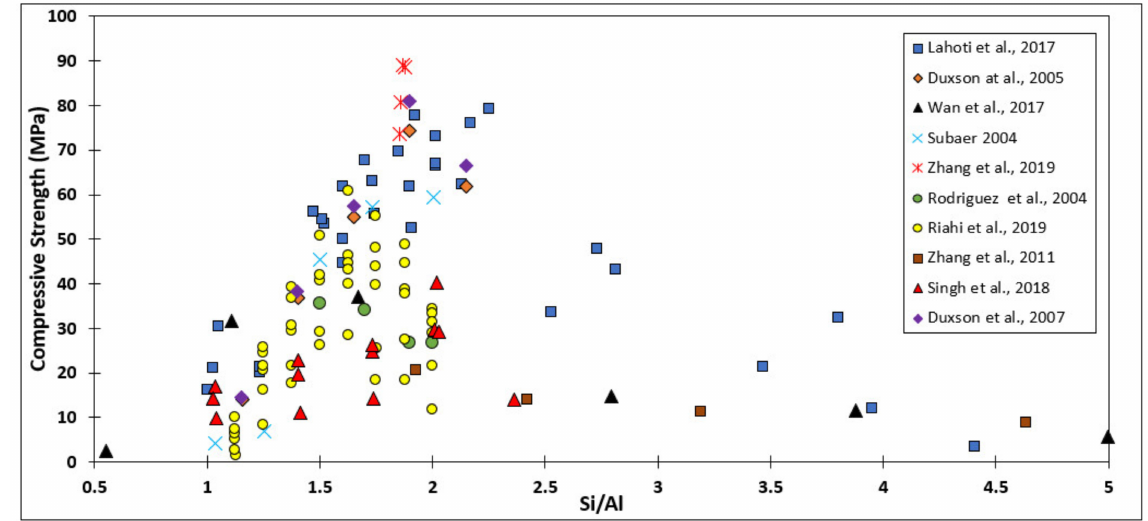
Figure 2. Graph compiling compressive strength vs. Si/Al ratio data obtained from previous investigations [17,25,28,30,31,